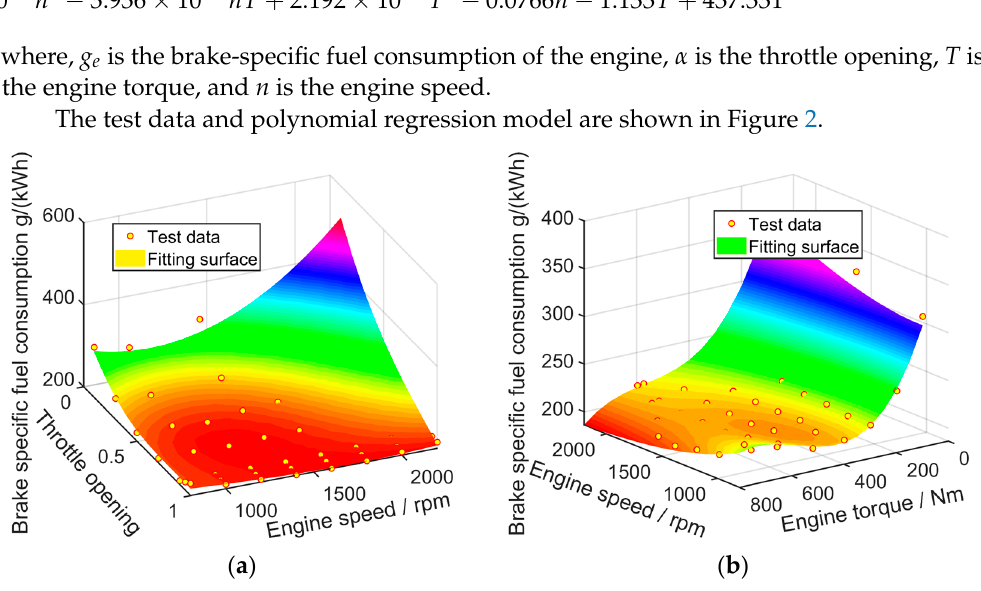
e = f ( α , n ); ( b ) g e = f ( n , T ).